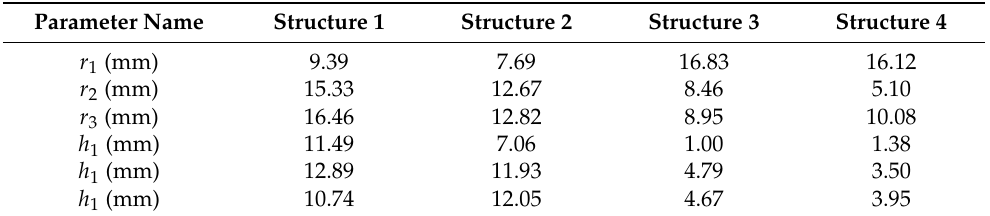
Figure 13. Optimized results (optimization goals are constrained).